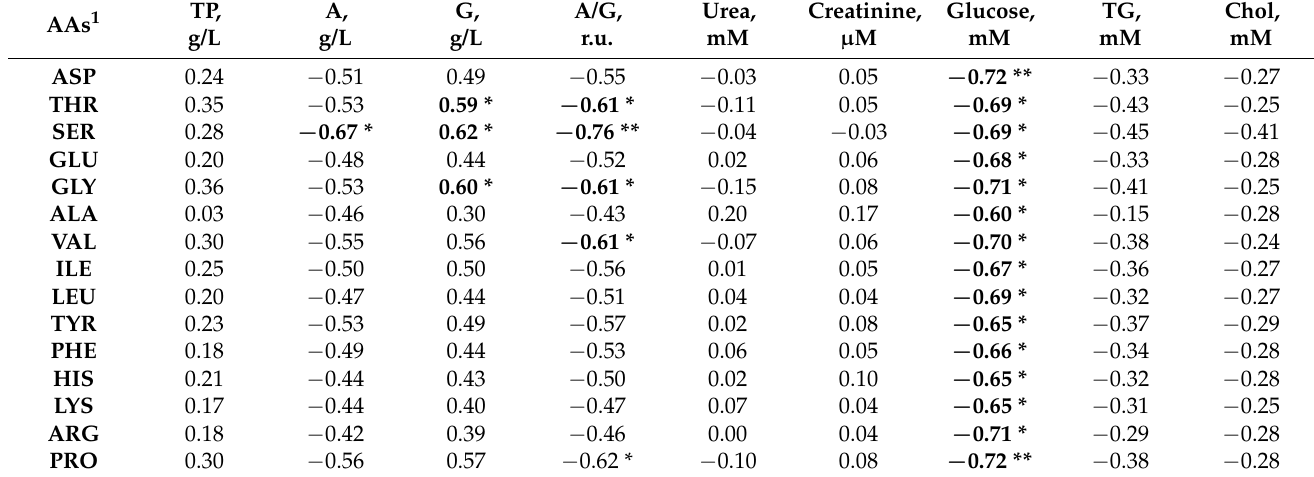
Table 2. The correlation coefficients between all obtained amino acids and the major biochemical parameters of the blood serum of Duroc pigs of the group 1 (65 days). TP, total protein; A, albumins; G, globulins; A/G, albumins to globulins ratio, urea, creatinine, glucose; TG, triglycerides; Chol, cholesterol (n =